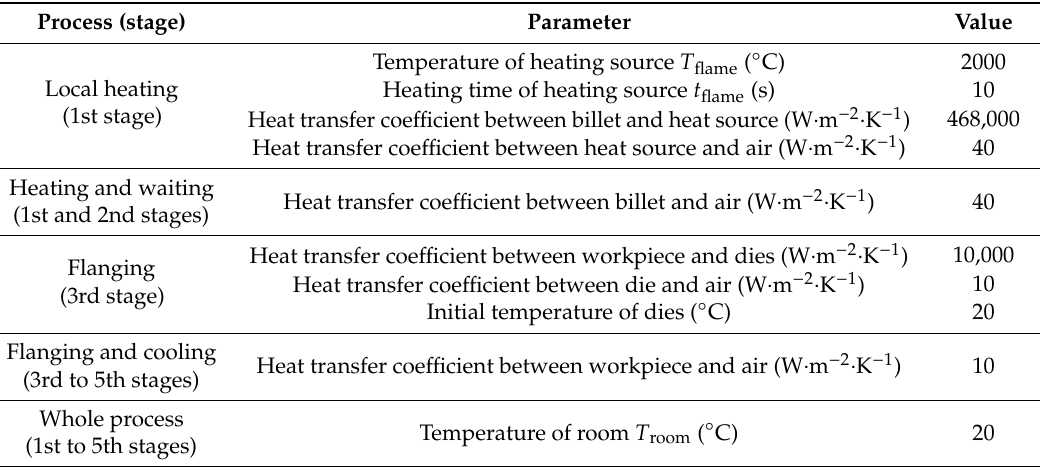
Table 3. Parameters about heat in the simulation.